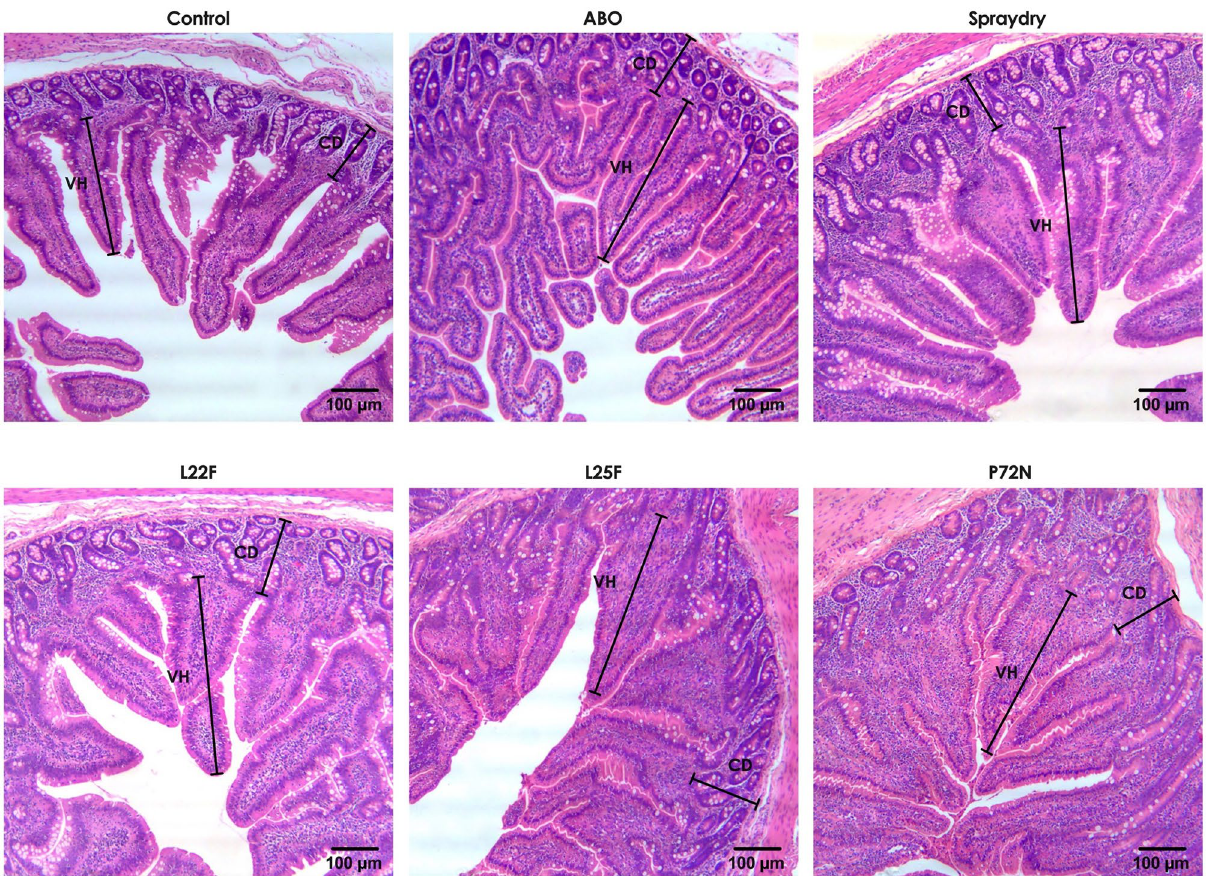
Figure 3. Representative intestinal morphology (jejunum) of pigs in each experimental group at week